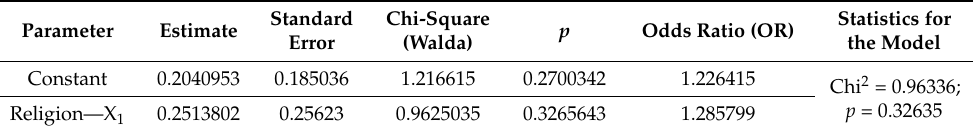
Table 10. Logistic Regression Score (LRS)—assessment of the relationship between the religion variable and the probability of increased homocysteine